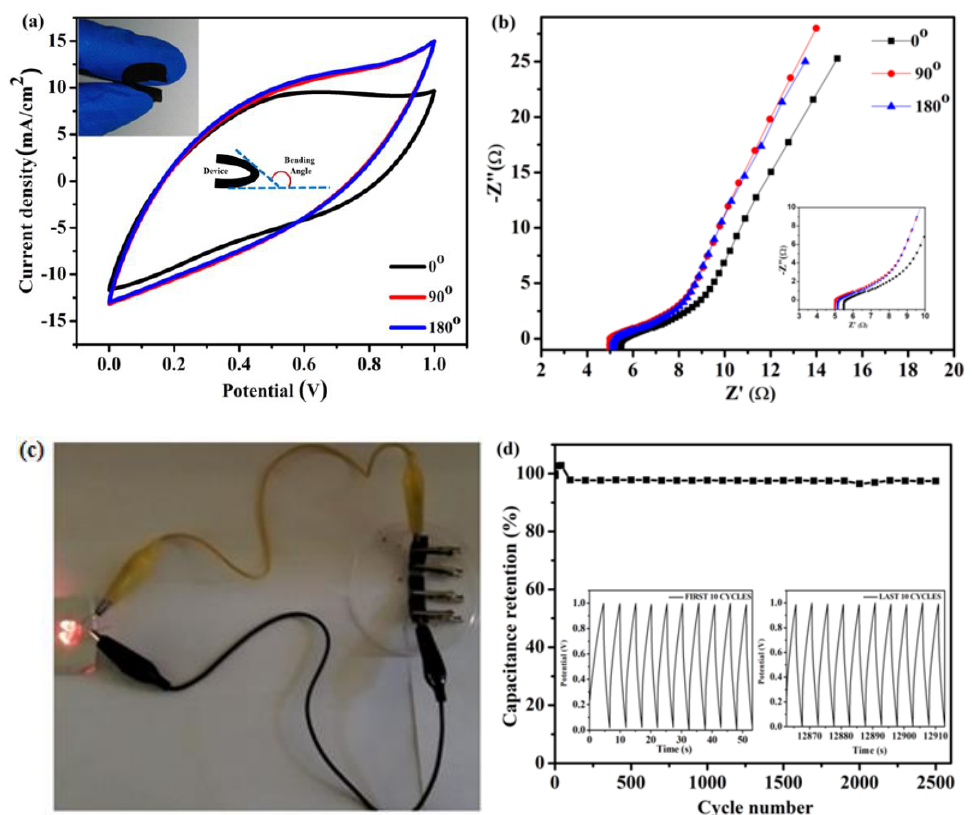
Figure 7. ( a ) CV curves recorded at various scan rates, ( b ) GCD curves recorded at various current densities, ( c ) Nyquist plots recorded over the frequency range from 0.01 Hz to 100 kHz, and ( d ) Ragone plot (power density vs. energy density) of the assembled all-solid-state symmetric SC.